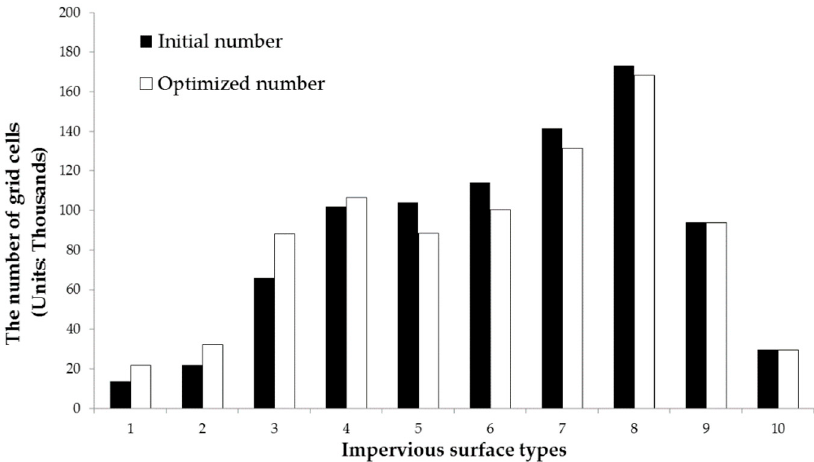
Figure 10. Statistics of impervious surface type before and after optimization.